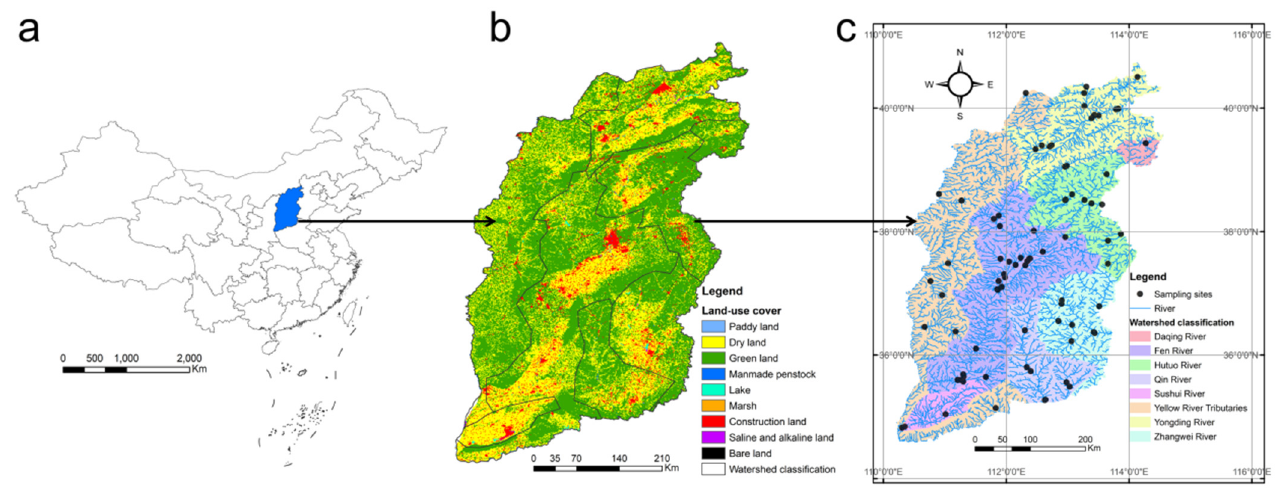
Figure 1. Location ( a ), land-use cover pattern ( b ), and watershed delineation ( c ) in Shanxi Province.